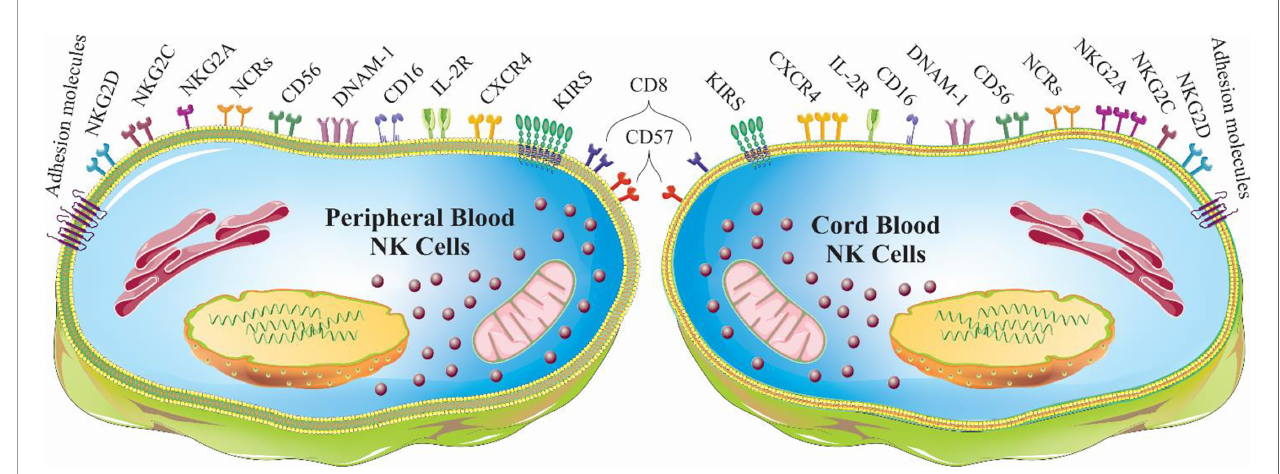
FIGURE 3 | Differences between UCB-NK cells and PB-NK cells phenotypic attribute. UCB-NK cells show lower expression levels of CD16, CD2, CD11a, CD18, CD62L, KIRs, DNAM-1, NKG2C, IL-2R, CD57, and CD8 along with higher expression levels of NKG2A and CXCR4 compared with PB-NK cells. UCB, Umbilical cord blood; PB, Peripheral blood; KIRs, Killer Ig-like receptors; DNAM-1, DNAX accessory molecule-1; NKG2C, NK cell group 2 isoform C; NKG2A, NK cell group 2 isoform A; CXCR4, C-X-C chemokine receptor type